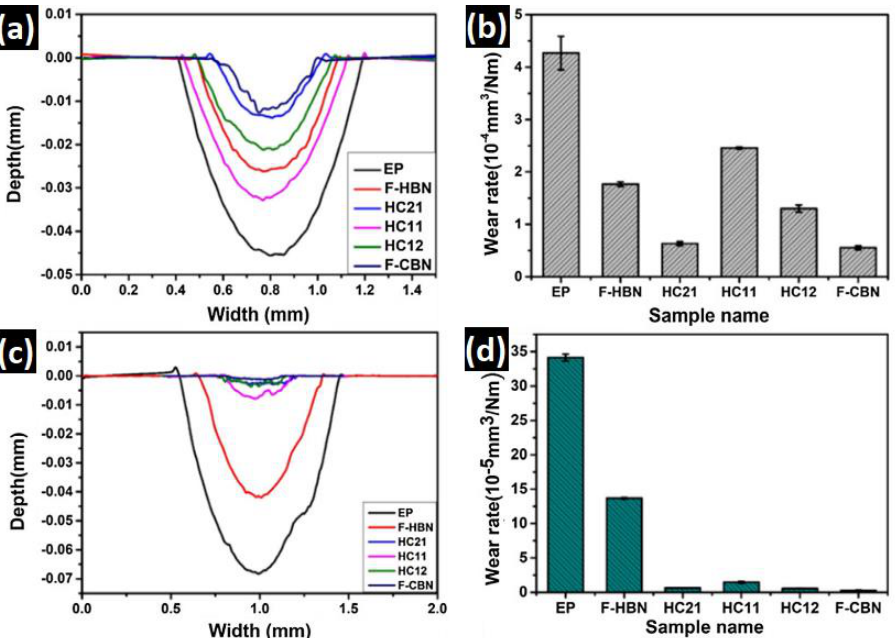
Figure 15. Cross-section profiles of the h-BN@PDA / c-BN@PDA / epoxy coatings ( a ) under dry sliding, and ( c ) seawater condition; wear rate of the h-BN@PDA / c-BN@PDA / epoxy coatings in ( b ) dry sliding, and ( d ) seawater condition (Reprinted with permission from Elsevier, Copyrights 2019) [138].